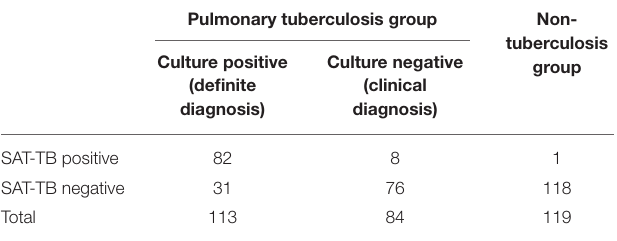
TABLE 2 | SAT-TB test of BALF for diagnosis of smear-negative pulmonary tuberculosis.